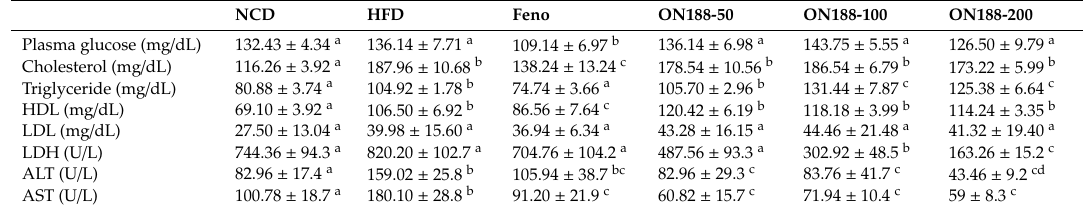
Table 1. Plasma biochemical parameters of mice with various